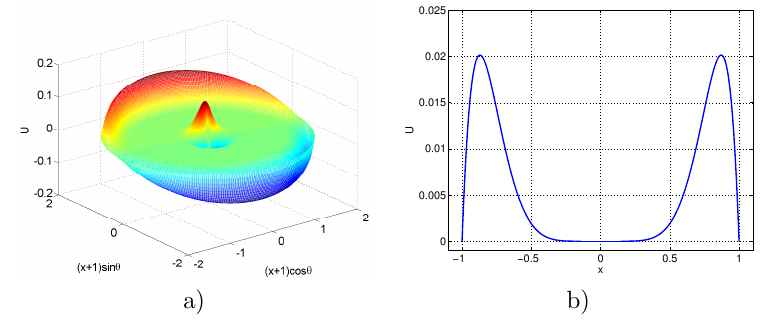
Figure 3. U ( x,θ,t ): a) in a disc with t = 2, b) against x with θ = 0 and t = 2.